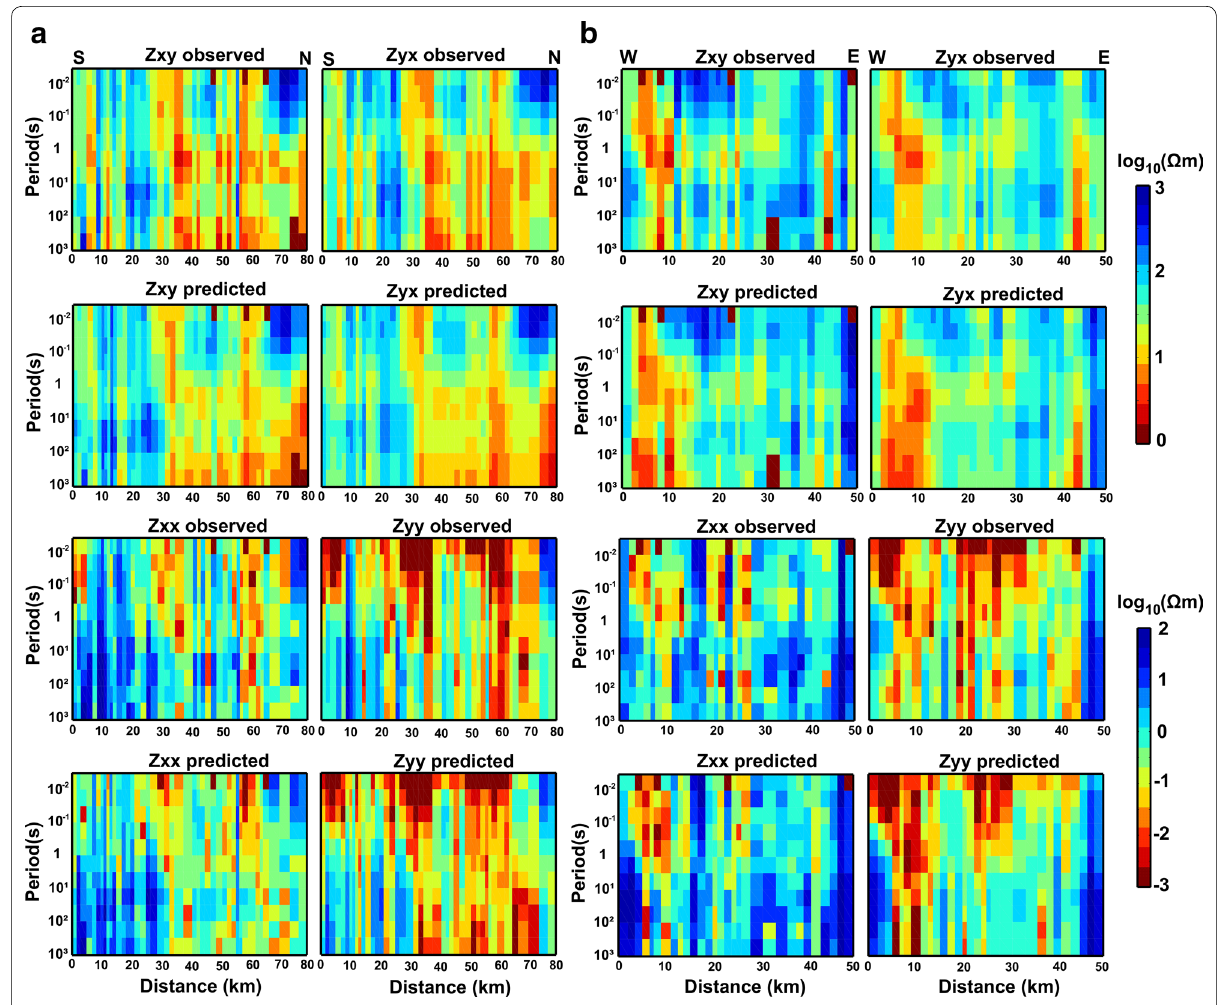
Fig. 7 Observed and predicted pseudo-sections of impedance tensor elements for G1 ( a ) and G2 ( b )